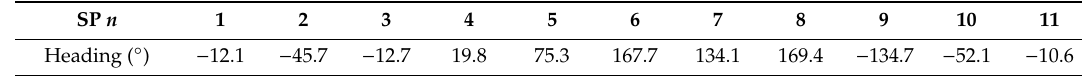
Table 6. The dominant directions of the straight paths.